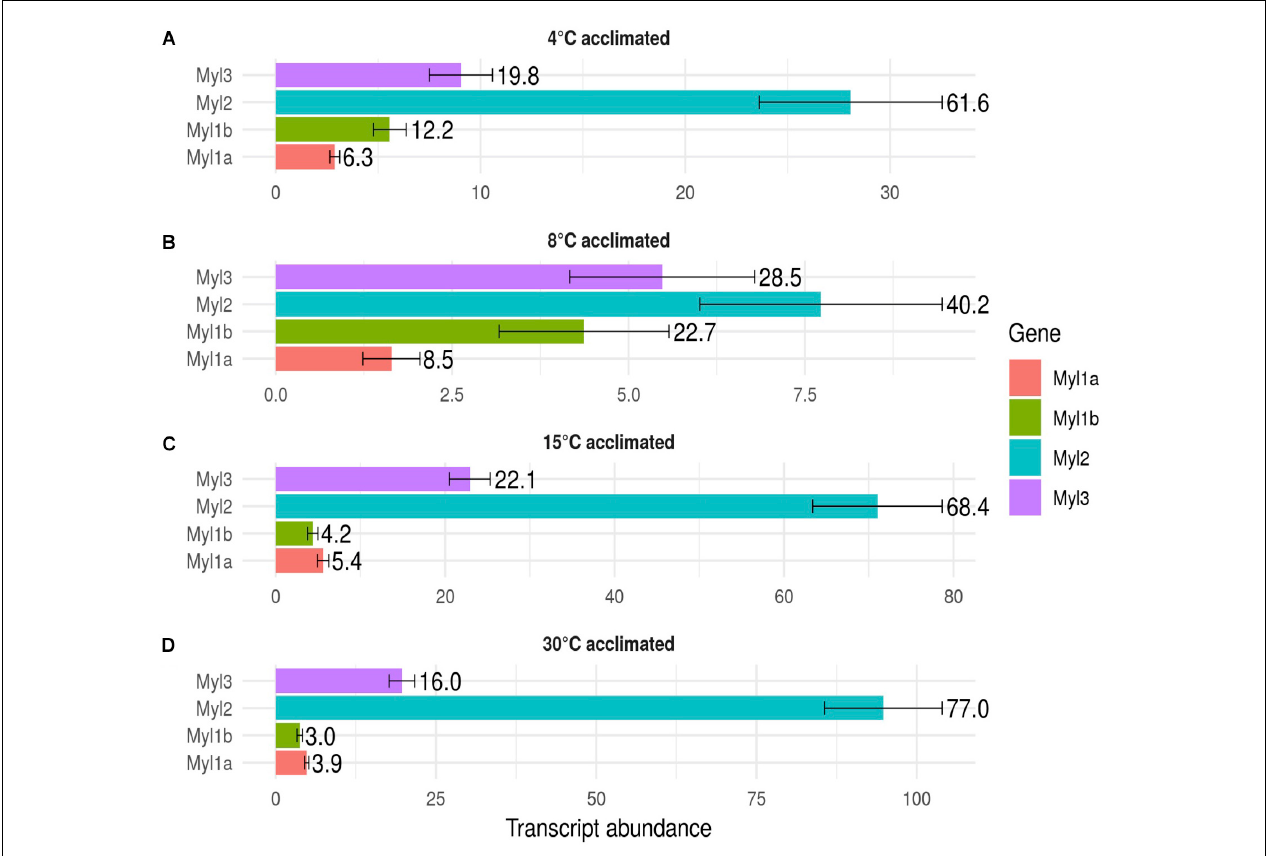
FIGURE 4 | Transcript abundance of the main myosin light chain isoforms in goldfish fast skeletal muscle. Values represent Mean ± SD transcript copy number normalized to the reference gene. The transcripts of myosin light chain orthologs myl1a (red), myl1b (green), myl2 (blue), and myl3 (purple) in response to long-term acclimation to 4, 8, 15, and 30 ◦ C are illustrated. To ease interpretation, the percentage of each transcript is shown to the right of each bar. (A) 4 ◦ C acclimated, (B) 8 ◦ C acclimated, (C) 15 ◦ C acclimated and (D) 30 ◦ C